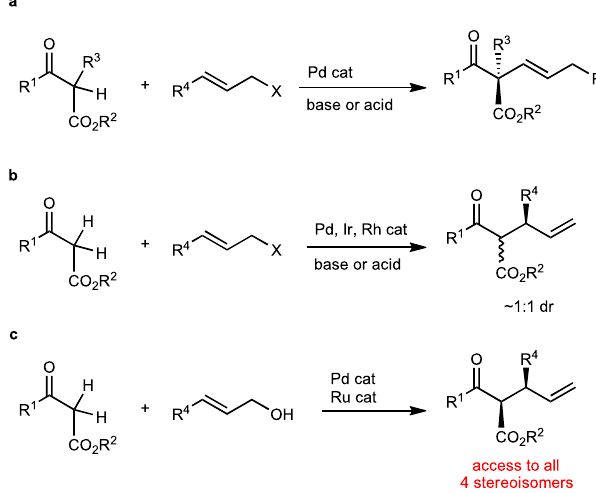
Fig.1|Enantioselectiveallylationof β -ketoesters.a Enantioselectiveallylationof α -monosubstituted β -ketoester. b Enantioselectiveallylationofanunsubstituted β - keto ester. c Stereodivergent allylation of β -keto ester (this work).